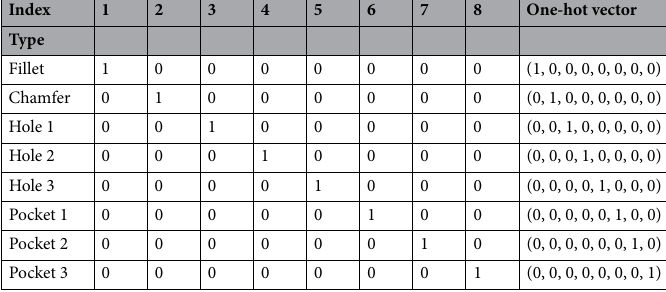
Table 4. Definition of one-hot vector label for machining